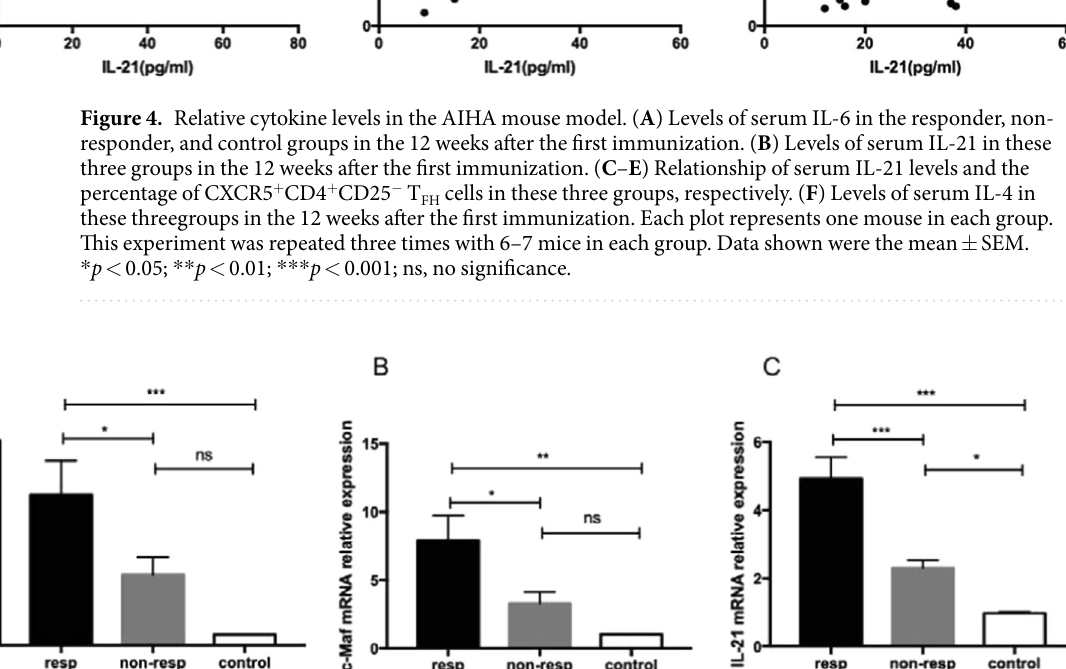
of CXCR5 + CD4 + CD25 − Foxp3 − T FH cells in the responder group (Fig. 4C). Besides, there was a moderate and positive correlation between IL-21 level and CXCR5 + CD4 + CD25 − Foxp3 − cells in the non-responder group and no significant correlation was found in the control group (Fig. 4D,E). No predictive relationship between serum IL-6 level and this parameter in all the three groups was found (data not shown). Besides IL-21, IL-4 is another cytokine secreted by T FH cell and no difference was found among three groups (Fig. 4F). Bcl-6, c-Maf, and IL-21 mRNA expression in the AHIA mouse model. The transcriptional factors of Bcl-6 and c-Maf as well as cytokines IL-21 play crucial roles in the generation, differentiation, and function of T FH cells 11 . The mRNA expression of Bcl-6, c-Maf, and IL-21 was assessed in these three groups, respectively, which were notably higher in the responder group than the control group (Fig. 5).